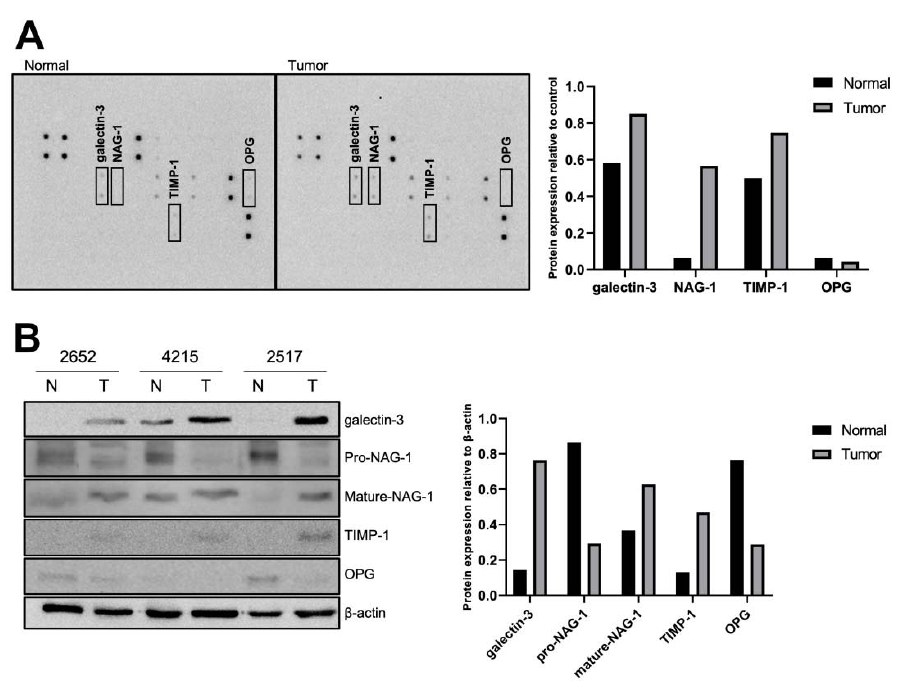
Figure 1. Antibody array using human thyroid tissues. ( A ) Antibody array (RayBio ® C-Series Human Cancer Discovery Antibody Array 3, RayBiotech) showed that 30 cytokines related to cancer biology were differentially expressed between thyroid normal and tumor tissues. One pair of PTC samples was used to analyze the expression of these cytokines. Four different proteins (Galectin-3, NAG-1/GDF15, TIMP-1, and osteoprotegerin) were selected as biomarker candidates for the diagnosis of thyroid cancer (rectangle). The right graph represents the intensity of each protein. ( B ) Western blot was performed using three pairs of PTC samples to confirm the data of antibody array. The protein expression of galectin-3, mature NAG-1, pro-NAG-1, TIMP-1, and OPG was examined using thyroid tissue samples. The right graph is from the average quantification of protein expression from three patients. N, thyroid normal tissue; T, thyroid tumor tissue. The number of patients is indicated (see Table 1 for details). Uncropped versions of blots presented in Figure S2 and Figure S3.